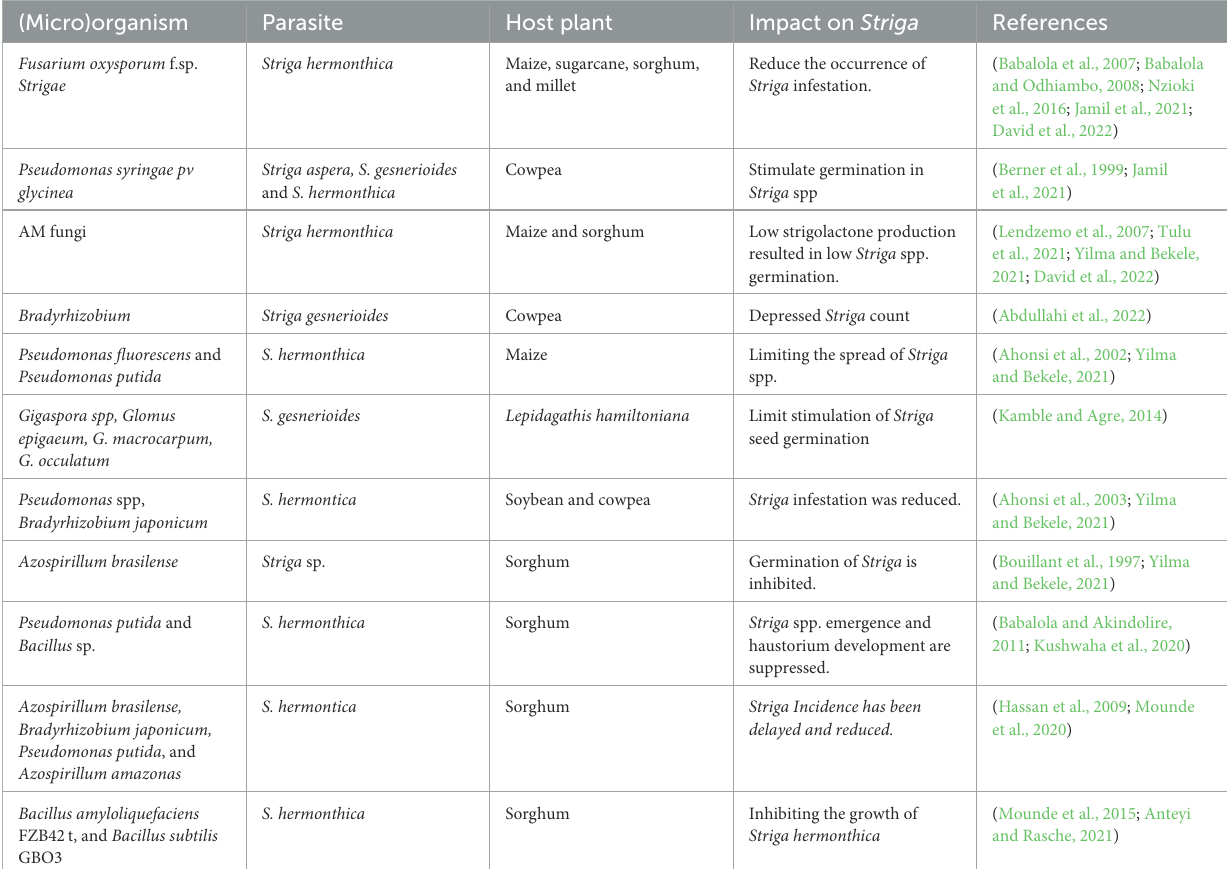
TABLE 1 Tripartite interaction between host plant, Striga spp., and associated